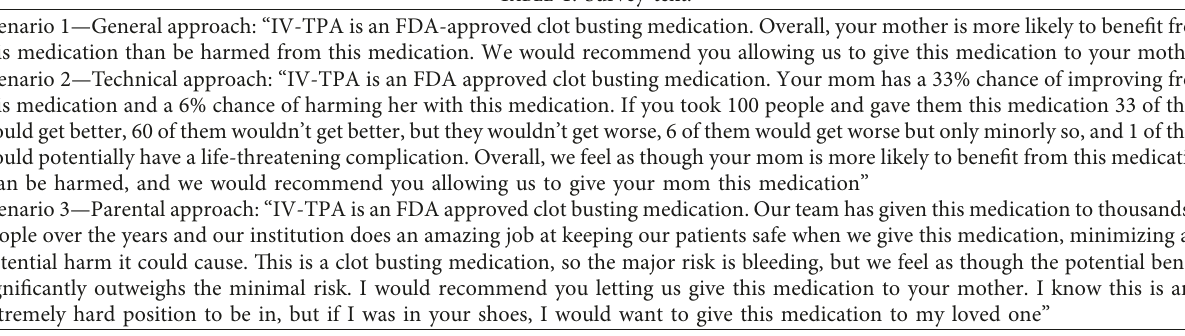
Table 1: Survey text.